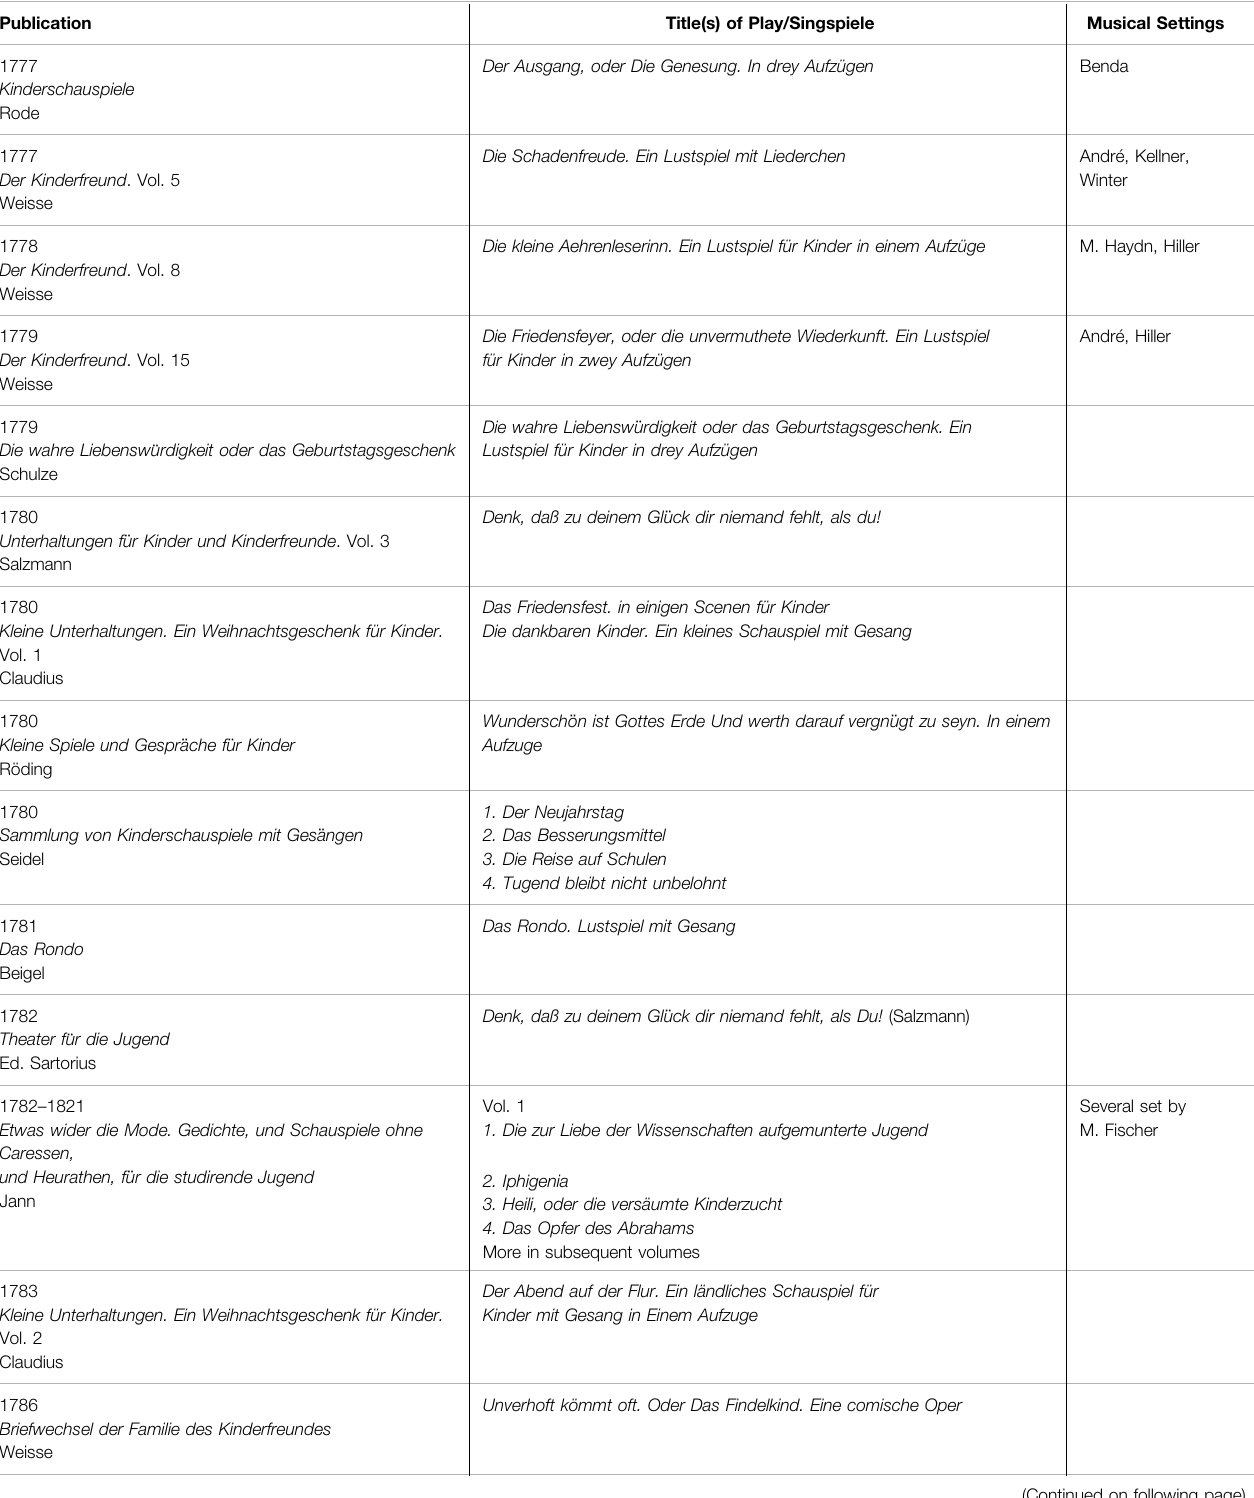
TABLE 2 | Selected Children ’ s Theatricals with Vocal Ensembles for Multiple Family Members, 1760 – 1800. Italics are the titles of individual